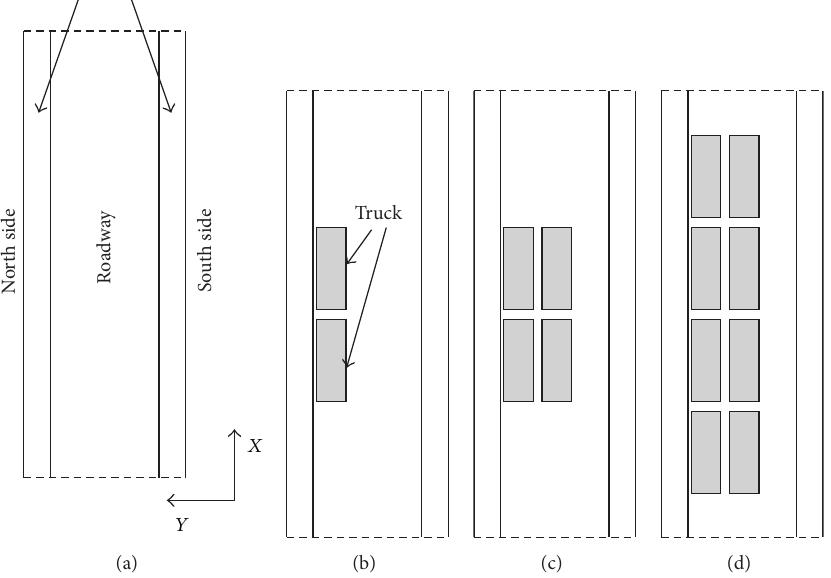
Figure 7: Upward view of the span which illustrates the sequence and the placing of the loads: (a) unloaded; (b) 2 truks; (c) 4 trucks; and (d) 8 trucks.